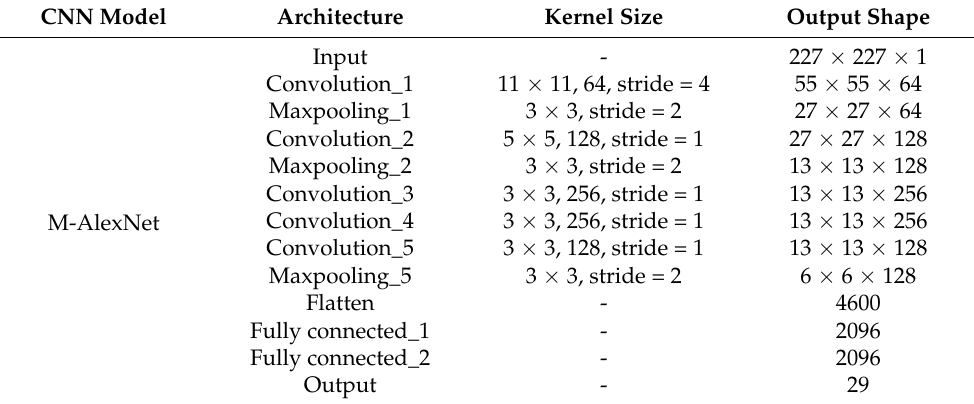
Table 2. The architecture of